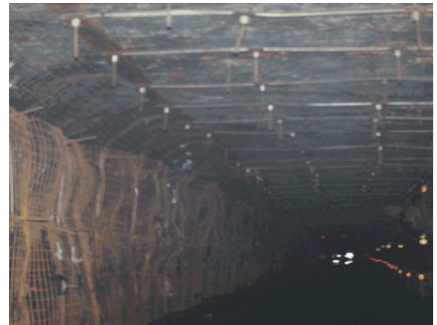
Figure 20: Roadway support parameters optimization